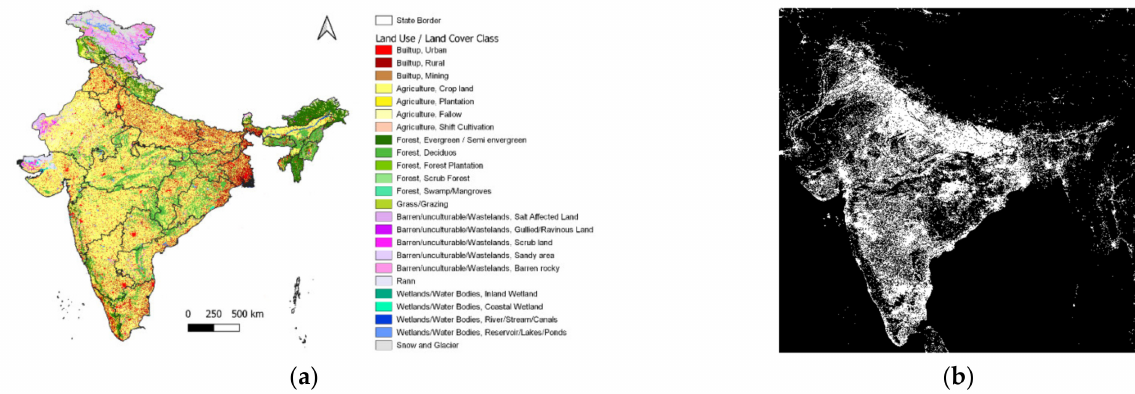
Figure 14. ( a ). Land use/land cover map for India. ( b ). Binary background mask from the 2019 annual VIIRS Nighttime Light (VNL) product. Source: